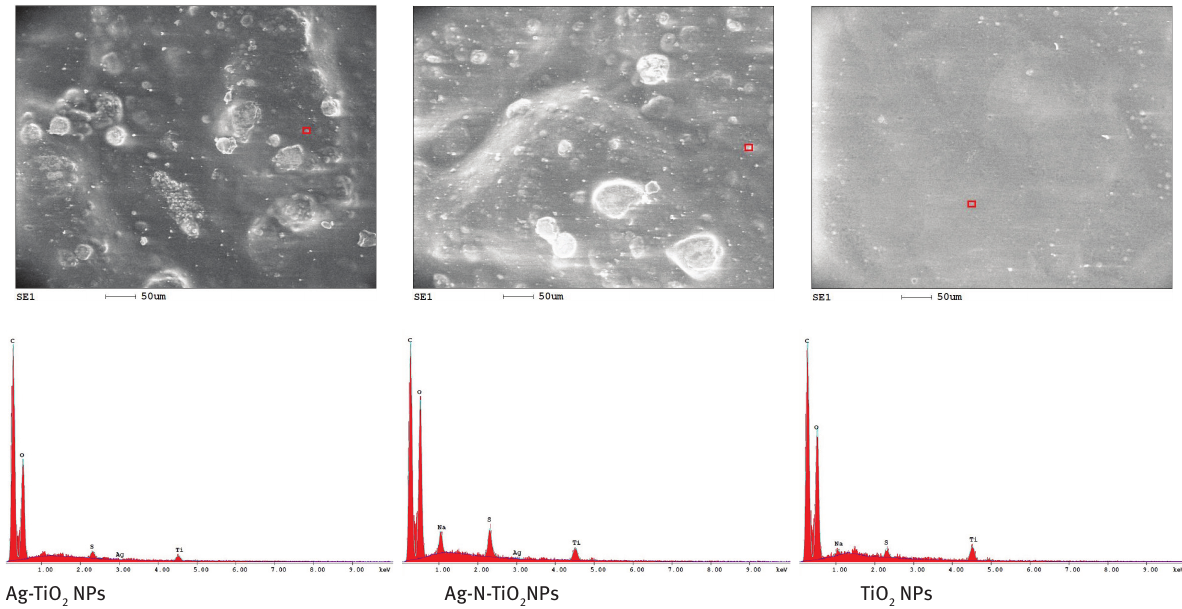
Figure 8: Leather surface morphology and Ag identification by SEM/EDX.